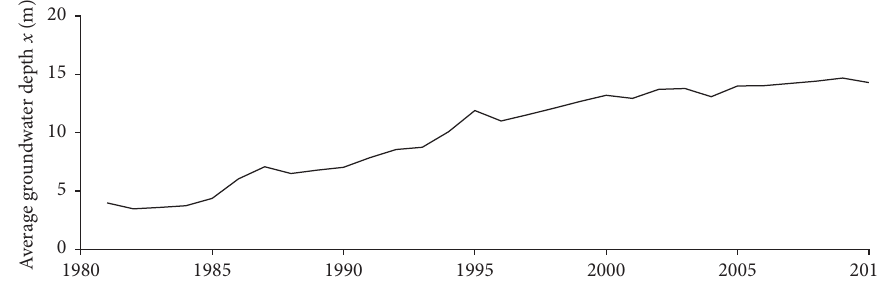
Figure 3: The average groundwater depth of the study area from 1981 to